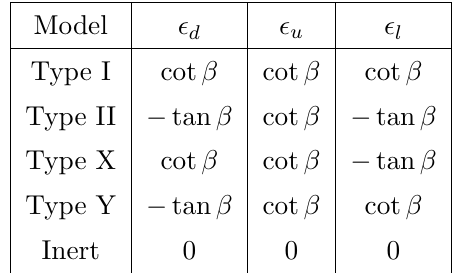
Table 1 . Values of the coe(cid:14)cients (cid:15) u;d;l which correspond to models with discrete Z 2 symmetries.